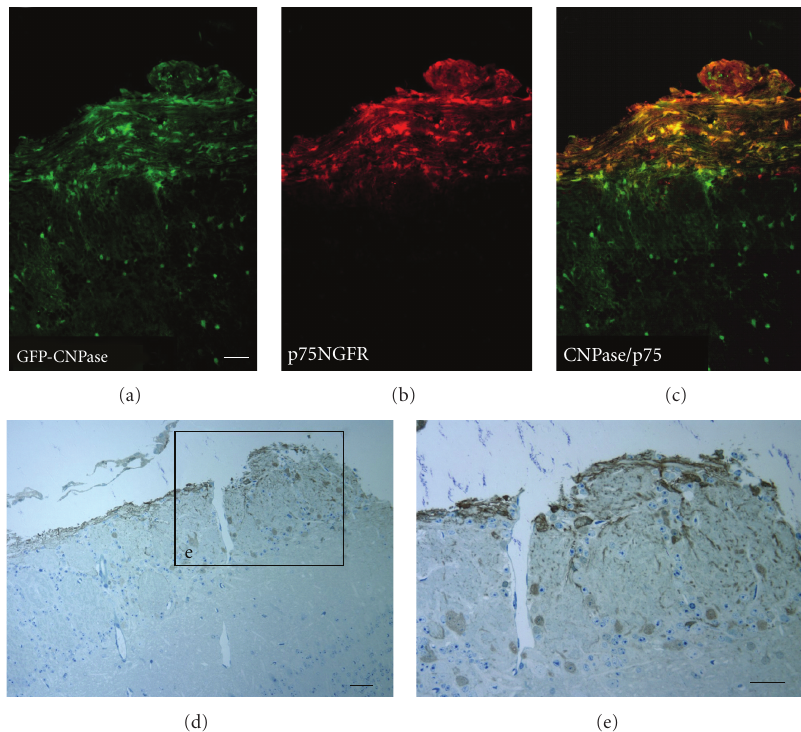
Figure 2: Colocalization of p75NGFR/CNPase and Immuno-EM. (a) GFP expression in the CNPase mouse in the olfactory nerve as it enters the OB and in scattered cells in the deep OB white matter. Immunostaining for p75 colocalizes with GFP in the olfactory nerve, but not in deep white matter (a–c). Immunoperoxidase staining for GFP in toluidine blue plastic sections (1um) shows that the GFP was present in OECs in the outer nerve layer (d, e). Scale bars: in (a), pertains to (a–c) = 10 µ m, (d) = 7, (e) = 10 µ